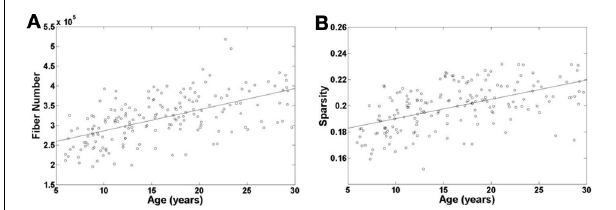
FIGURE 2 | Age-related changes in fiber number and sparsity of white matter network in all the individual subjects. Both fiber number and sparsity demonstrate increases with